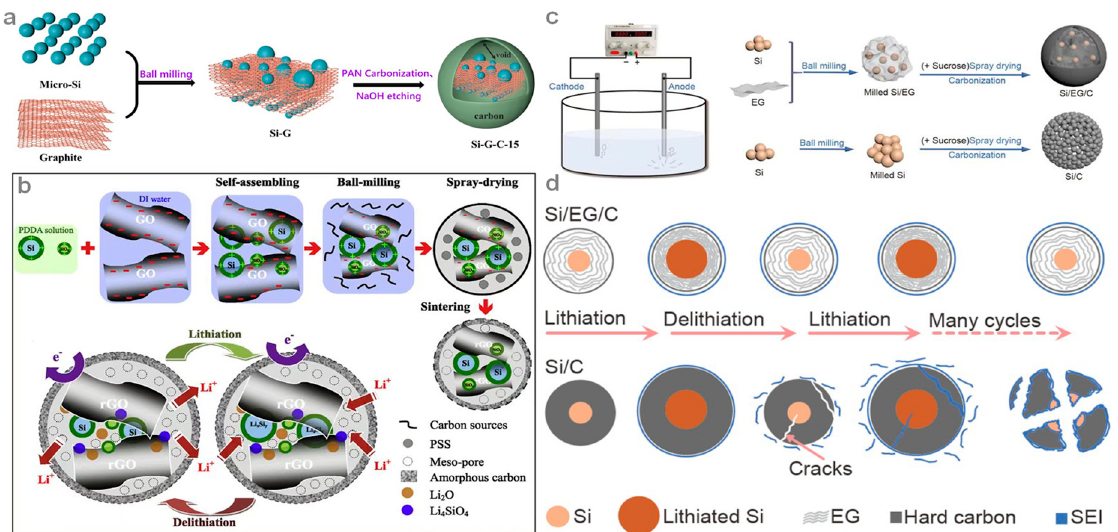
Figure 5. ( a ) Schematic diagram of Si-G-C-15 sample synthesis process. Reproduced with permis- sion [73]. Copyright 2022 Elsevier B. V. ( b ) Synthesis procedure of the ternary hierarchical Si/rGO/C composite microsphere and schematic diagram of electron (e − ), Li-ion (Li + ) pathways, and synchro- nous formation of inert products such as Li 2 O and Li 4 SiO 4 , which can not only act as disperse media to prevent from Si aggregation, but also serve as buffer matrix to tolerate the volume changes in Si nanoparticles (SiNPs), in the Si/rGO/C composite microsphere during the first lithiation process. Reproduced with permission [79]. Copyright 2019, Elsevier B. V. ( c ) Schematic illustration of the apparatus of the electrochemical exfoliation of graphite rods and the preparation process for Si/EG/C and Si/C. ( d ) Schematic illustration of Si/C and Si/EG/C during a charge–discharge cycle. Reproduced with permission [84]. Copyright 2022, Springer Nature.